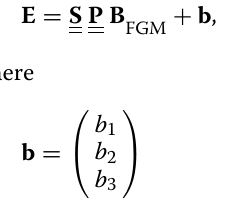
Fig. 1 The location of the three magnetometers (FGM x , x Medialab,